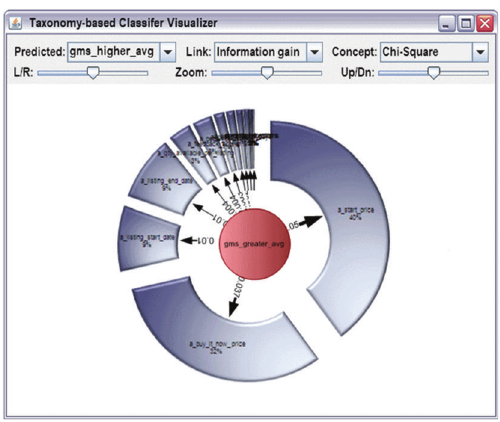
Figure 10: Visualization of attribute-to-class information at abstract level 3 (middle layer).